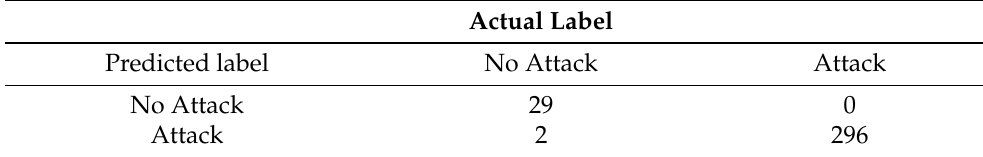
Table 22. Key logging DT confusion matrix.